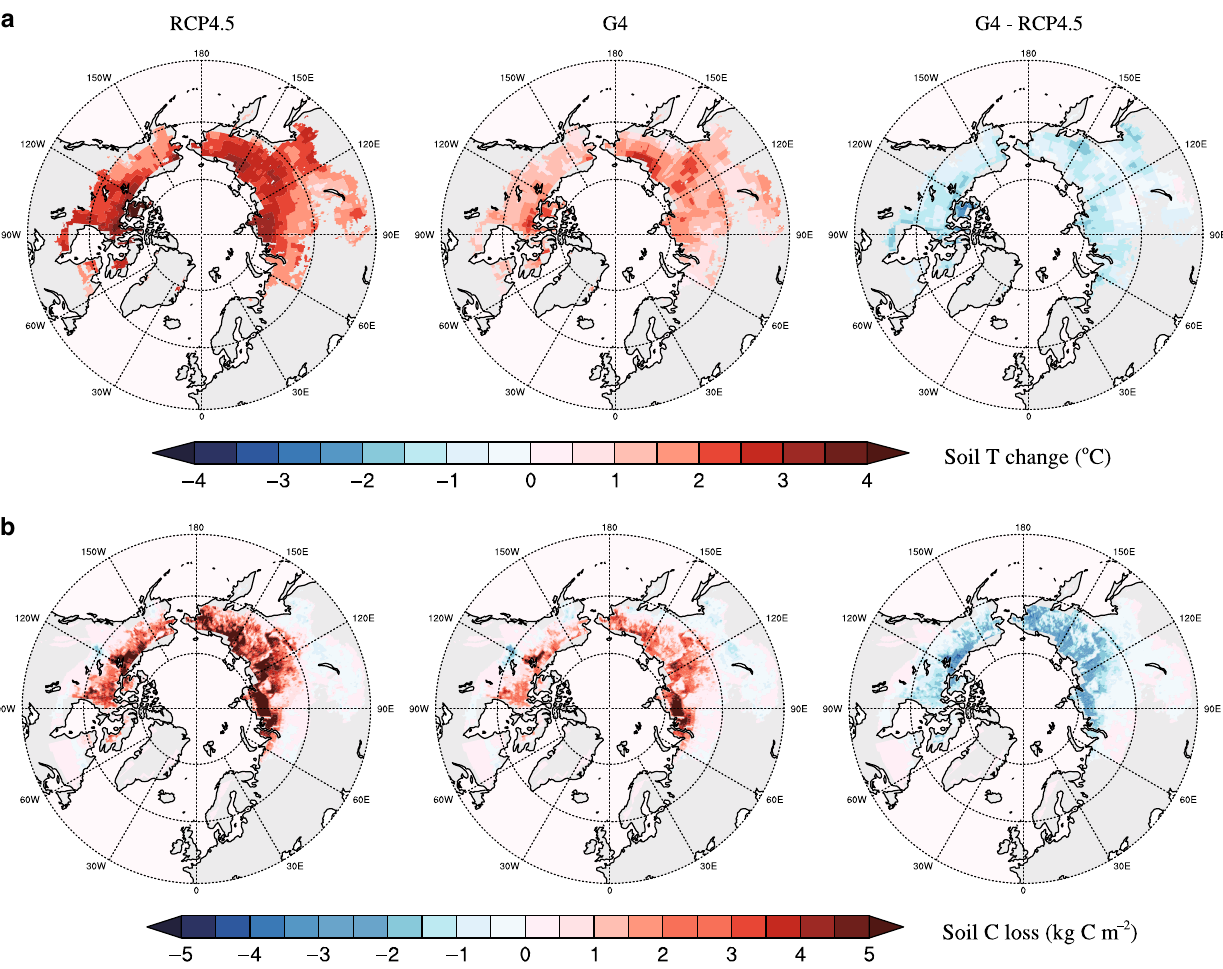
Fig. 2 The cooling effect of geoengineering and projected soil carbon loss. Ensemble mean spatial distributions of ( a ) permafrost soil temperature change in the upper 3 m of soils between 2020 and 2069 under the emission scenario RCP4.5 and the geoengineering experiment G4, as well as the difference (G4-RCP4.5), derived from the TSL outputs of 7 ESMs after bias-correction and ( b ) permafrost soil C loss from PInc-PanTher between 2020 and 2069, integrated from surface to 3 m depth. By combining the compiled soil carbon maps with laboratory incubation syntheses (Methods), PInc-PanTher provides data-constrained estimates on the permafrost C response to imposed climatic